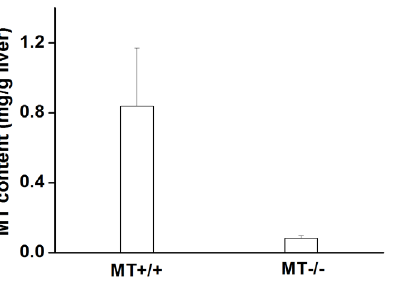
Figure 1. Hepatic MT concentrations in wild-type (MT + / + ) and MT 2 / 2 mice. The MTconcentrations in the livers of MT + / + and MT 2 / 2 mice were determined by cadmium-saturation assay. Data were expressed as means 6 standard deviations.